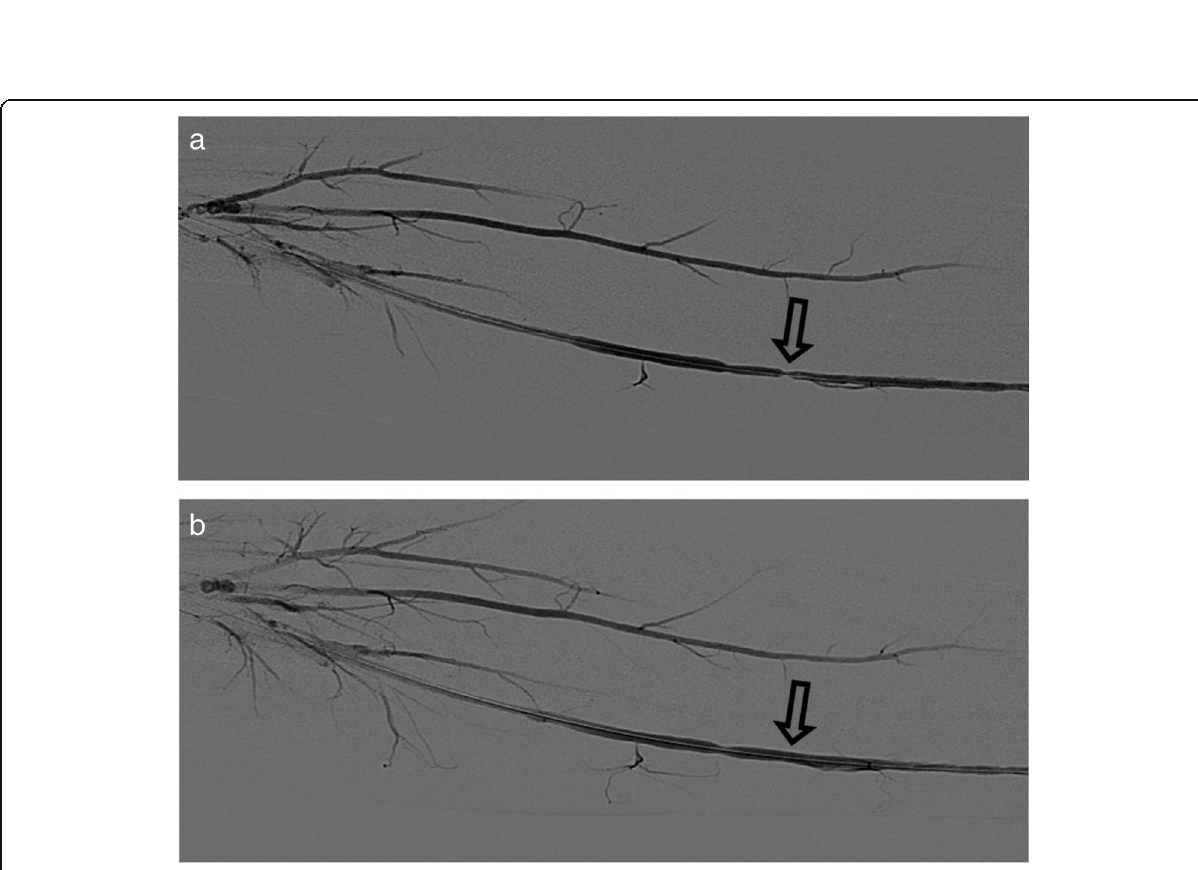
Fig. 3 Left brachial angiogram in a 27-year-old man with ESRD s/p pAVF creation. Pre angioplasty (top image) demonstrates severe stenosis in the mid ulnar artery (open arrow). Post angioplasty (bottom image) demonstrates improvement in the stenosis.Earlier opacification of the ulnar artery and significantly improved flow in the interosseous and the radial artery was also seen (not shown), suggesting decreased resistance within the arterial bed post angioplasty